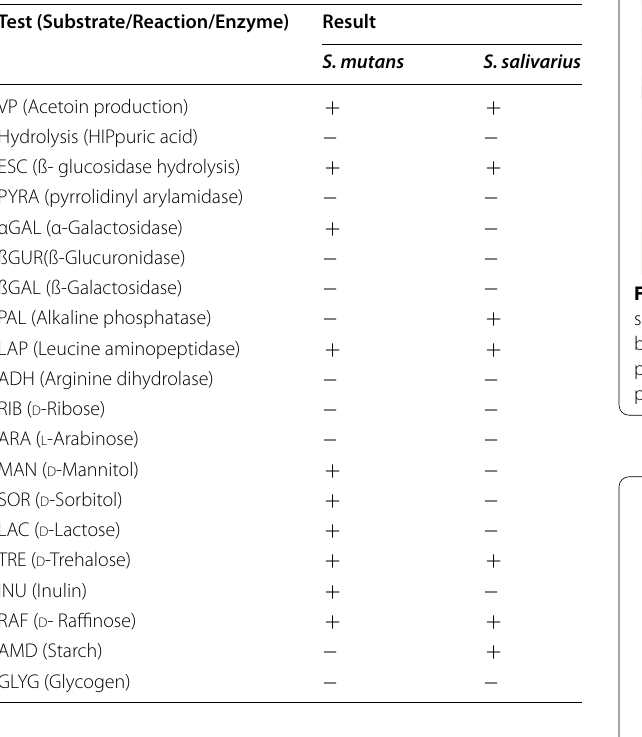
Table 2 Common biochemical characteristic reactions for S.